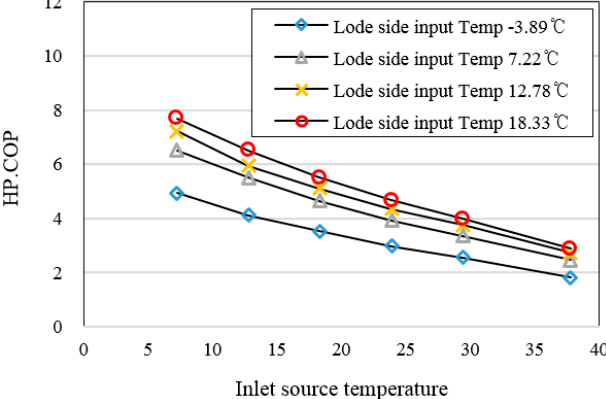
Figure 7. Cooling catalog data of heat pump.